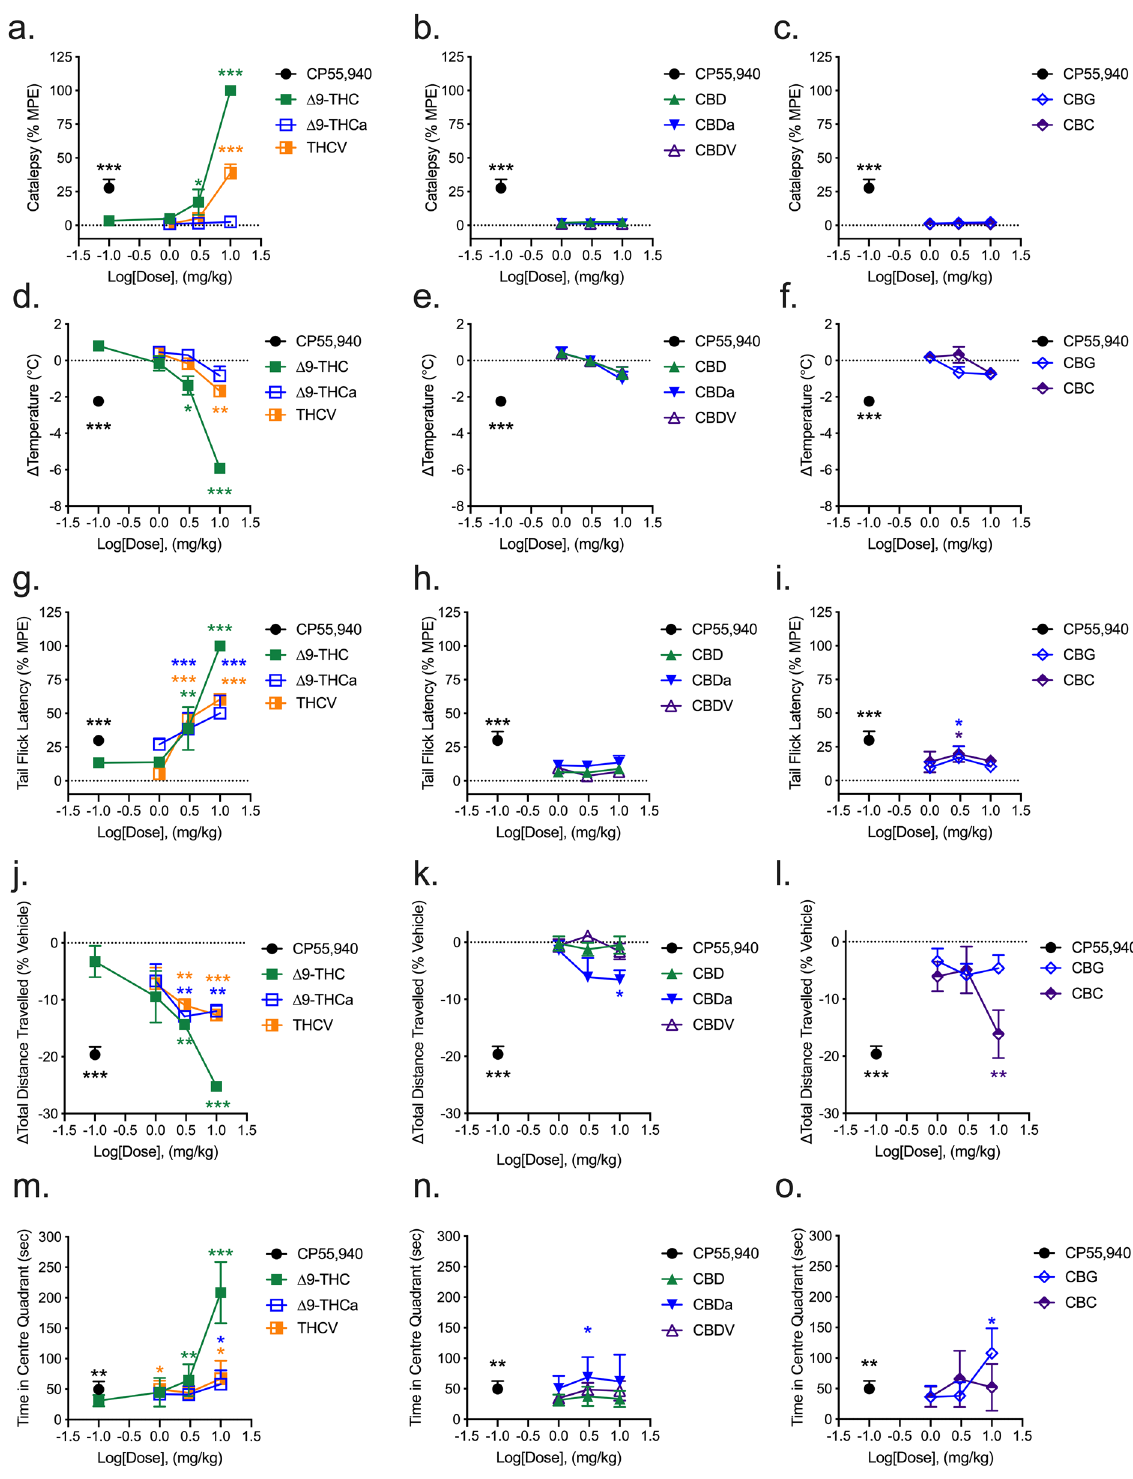
Figure 9. Acute tetrad effects in male C57BL/6 mice. Male mice aged 6–12 weeks were treated with 0.1–10 mg/kg i.p. of phytocannabinoids and assessed for catalepsy ( a – c , 5 min post-injection), body temperature ( d – f , 10 min post-injection), nociception in the tail flick assay ( g – i , 15 min post-injection), and both locomotion ( j – l ) and time in the centre quadrant ( m – o ) in the OFT 1 h post-injection. THC-like compounds are shown in panels a , d , g , j , and m . CBD-like compounds are shown in panels b , e , h , k , and n . CBG, and CBC are shown in panels c , f , i , l , and o . ( a – c ) Catalepsy data are expressed as the % maximum possible effect (MPE, i.e . 60 s). ( d – f ) Body temperature data are expressed as change (∆) from baseline (°C). ( g – i ) Tail flick latency data are expressed as the % maximum possible effect (MPE, i.e . 20 s). ( j – l ) Locomotion data are expressed as % change from baseline total distance travelled. ( m – o ) Time in centre quadrant data are expressed as sec during 5 min OFT trials. n = 6/treatment. All data are expressed as mean ± SEM. *p < 0.05, **p < 0.01, ***p < 0.001 relative to vehicle for each assay as determined via one-way ANOVA followed by Tukey’s post-hoc analyses. Asterisk colour matches the treatment group